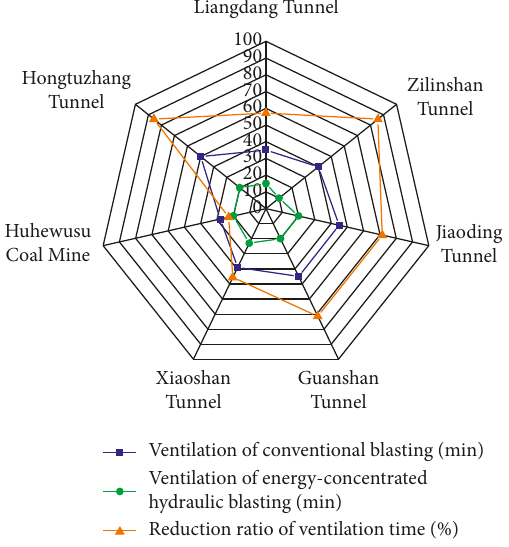
Figure 15: Comparison of ventilation time